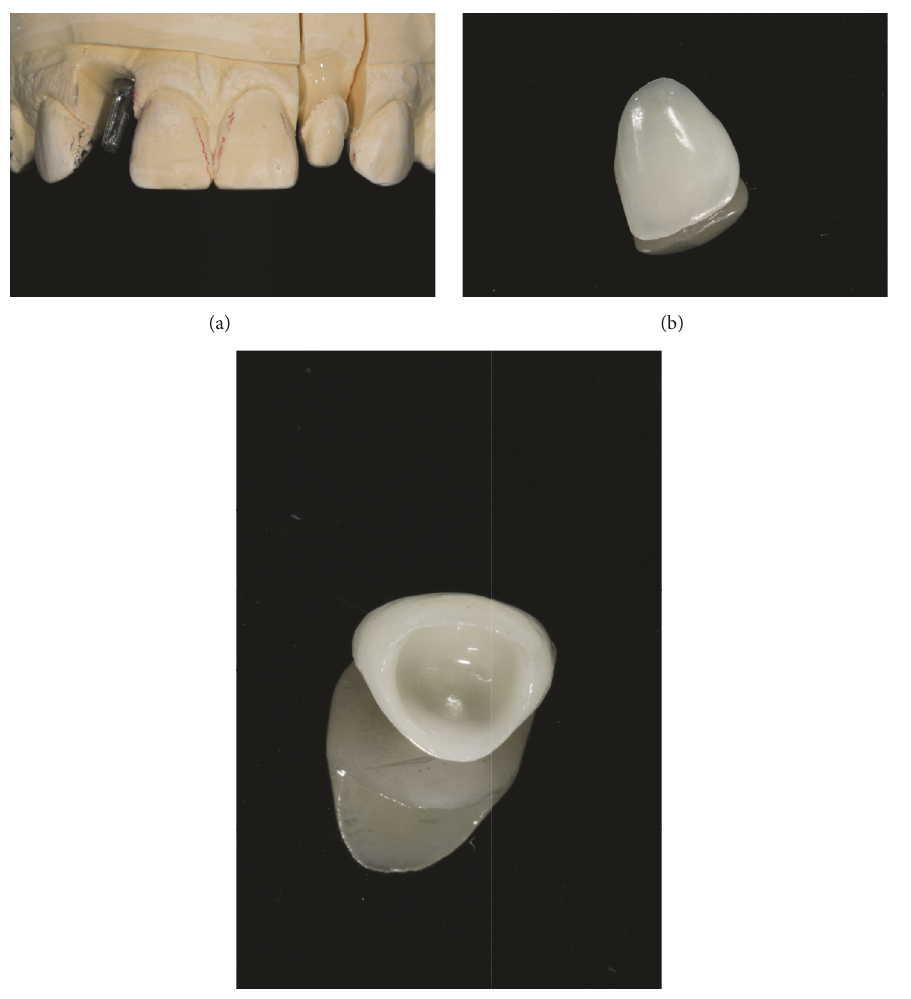
Figure 7: Model (a) with die. Reinforced ceramic with lithium disilicate in the BL4 color. External and internal aspects of ceramics on the microdont tooth after finishing (b and c).